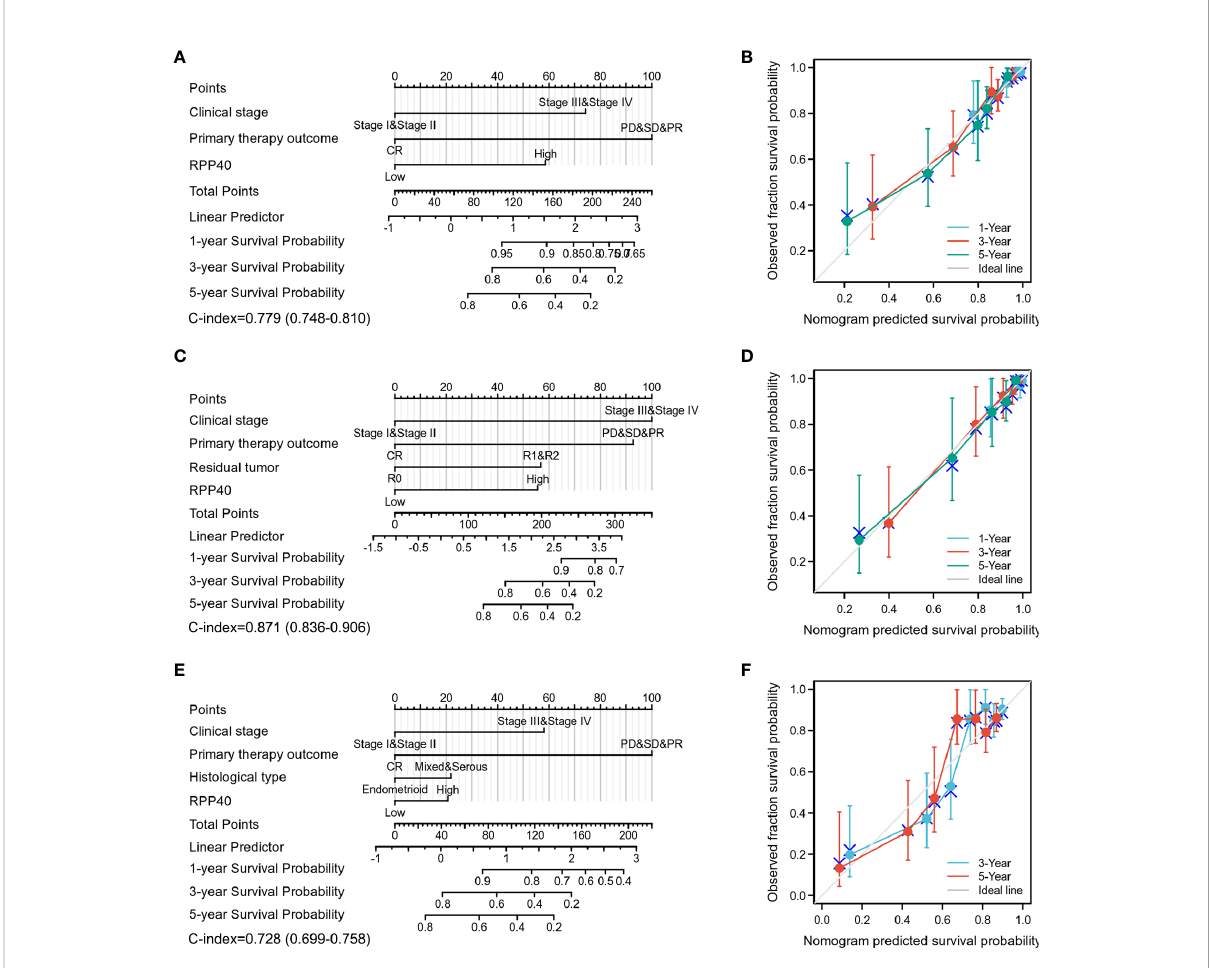
FIGURE 5 Construction and validation of nomograms in UCEC prognosis based on RPP40 expression. The nomograms were constructed to establish RPP40 expression-based risk scoring models for 1-, 3-, and 5-year OS (A) , DSS (C) , and PFI (E) . Calibration plots were drawn to validate the ef fi ciency of nomograms for OS (B) , DSS (D) , and PFI (F)